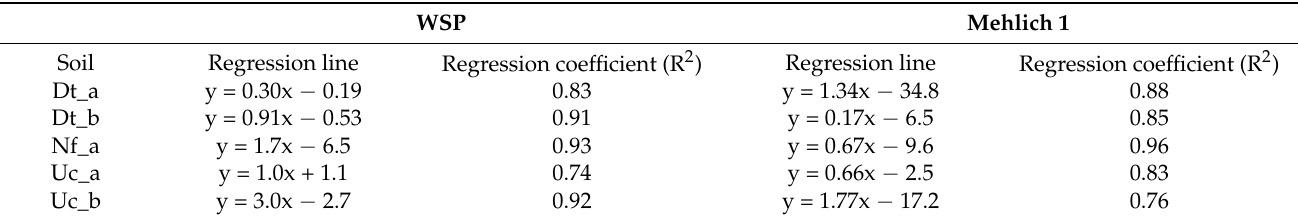
Figure 3. For the three low-Pi status soils (Uc_b, Uc_a, and Dot_b), the increasing K-Phi application rates resulted in significant increases in Mehlich 1 values ( p < 0.01). For in- stance, the “native” Mehlich 1 value for Uc_b was 4 mg kg − 1 in the control with a DLP release of 0.1 mg kg − 1 (2.5% cumulative P loss). Applying 24 and 49 kg K-Phi ha − 1 to Uc_b raised Mehlich 1 values to 17.1 and 28.7 mg kg − 1 with DLP releases of 3.32 (10% P loss) and 12.3 mg kg − 1 (20% P loss), respectively. The Uc_a_and the Dt_b followed a similar trend of increasing Mehlich 1 values at increasing rates of K-Phi application but with lower amounts of mean DLP losses than the Uc_b soil. However, in the two medium-Pi soils (Nf_a and Dt_a), increasing Mehlich 1 soil levels due to K-Phi application differed markedly on the DLP. The DLP values were low (<1%) from the controls of both Nf_a and Dt_a soils. Relative to the Phi application rates of 24 and 49 kg ha − 1 , K-Phi fertilizer addi- tion to the Nf_a soil increased P loss to 6 and 9%, whereas K-Phi fertilizer addition to the Dt_a soil at the highest rate of 49 kg ha − 1 resulted in a mean P loss of 1%.